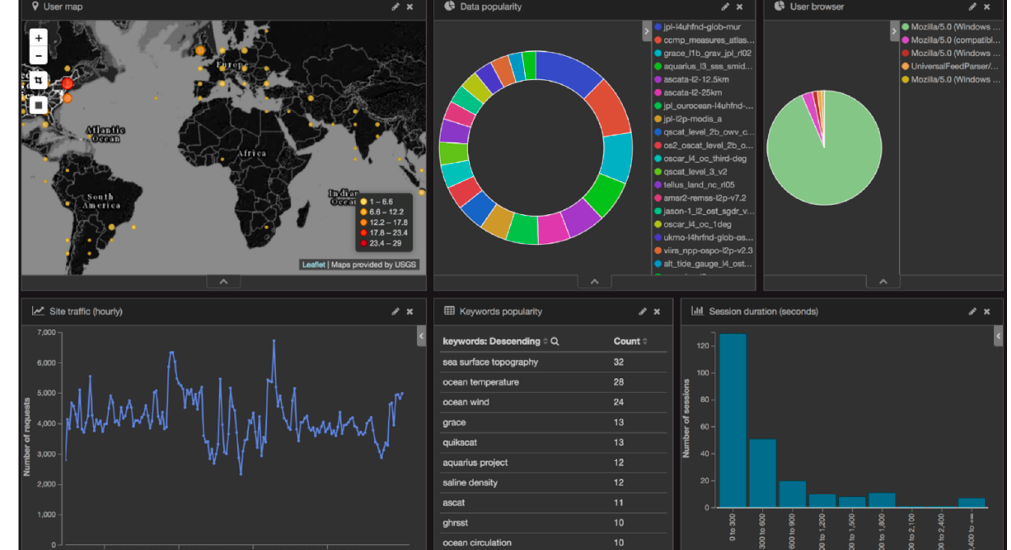
Figure 15. An example of the session tree structure [4].